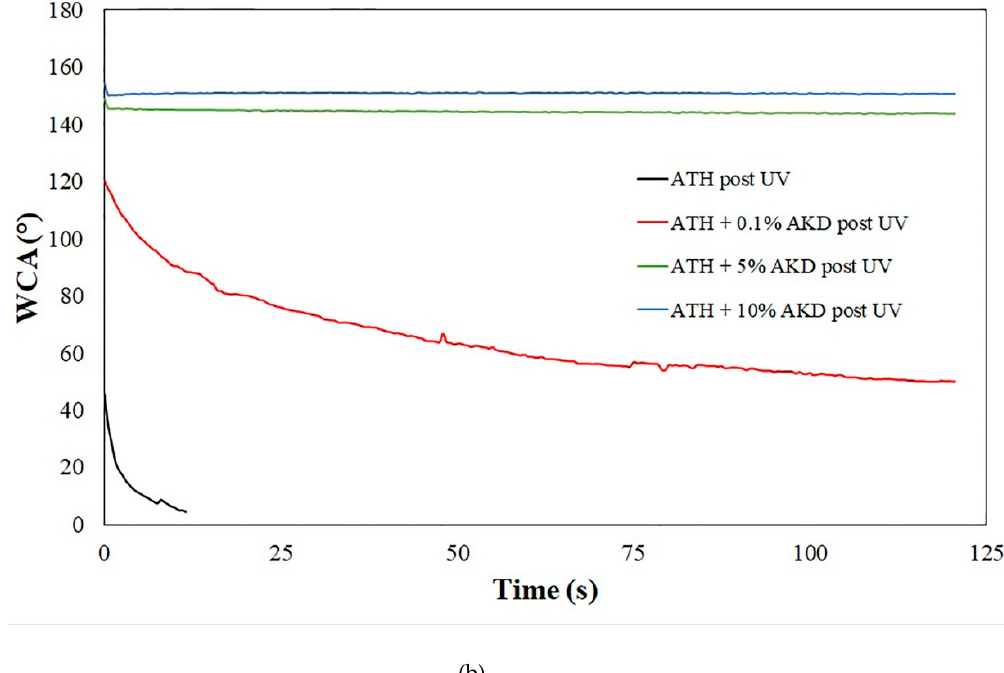
Figure 2. WCA during time on thermo-treated alder samples (ATH), before ( a ) and after UV exposure ( b ).